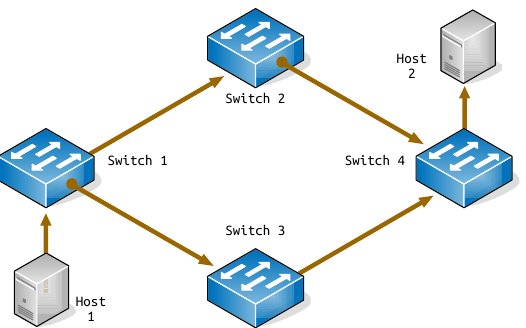
Figure 3. An example network ( D NET ) with diamond topology.